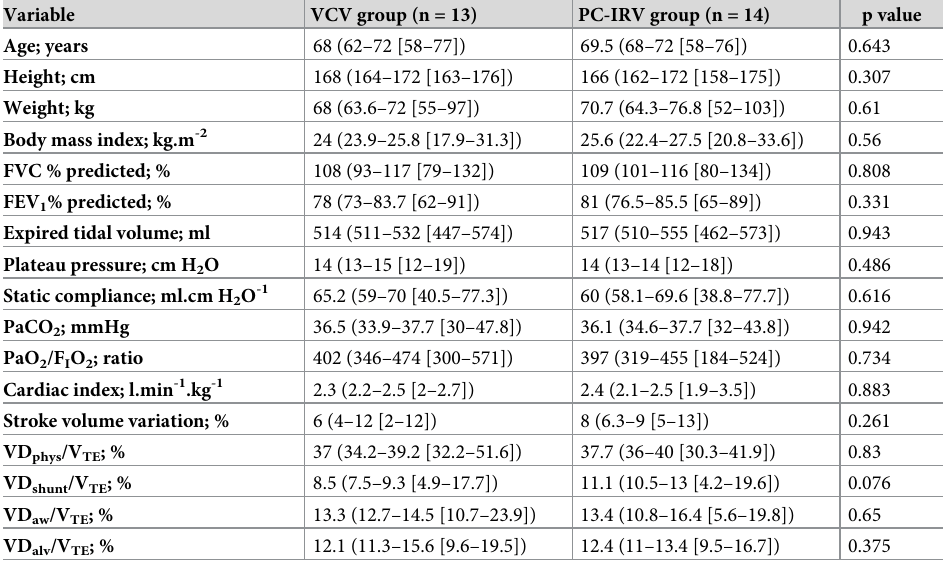
Table 2. Patient and surgical characteristics, and the respiratory and hemodynamic parameters at T Baseline (20 min after the initial setting). Variable VCV group (n =